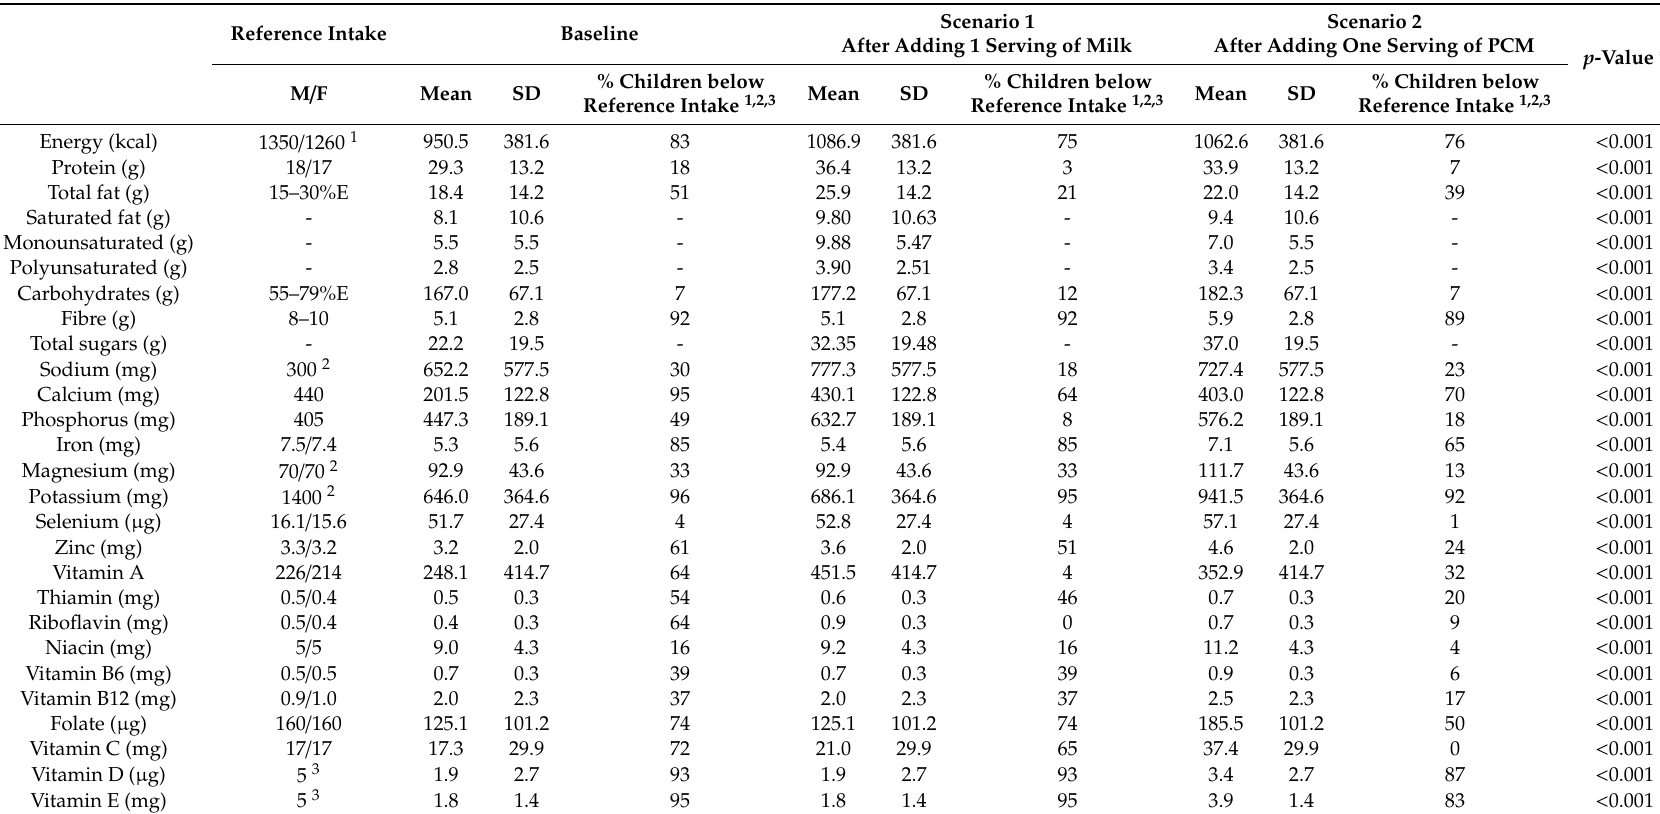
Table 4. Mean nutrient intakes and inadequacy at baseline and after modelling scenarios 1 and 2, in children aged five years ( n =